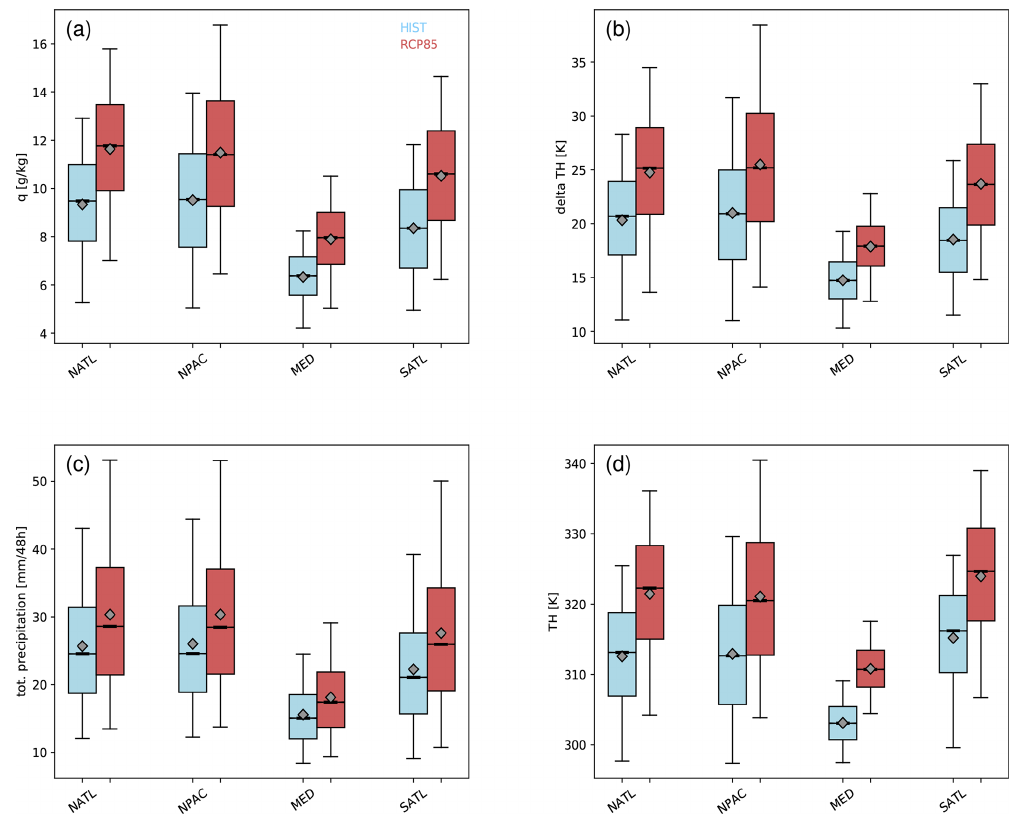
Figure 8. Box-and-whisker plots for different characteristics of WCBs in the North Atlantic (NATL), North Pacific (NPAC), Mediter- ranean (MED), and South Atlantic (SATL). The panels show (a) specific humidity in the WCB inflow, (b) the increase in potential tempera- ture along the WCB, (c) accumulated surface precipitation along the WCB, and (d) potential temperature at the end of the WCB ascent. Only winter is considered, i.e. DJF for NATL, NPAC, and MED and JJA for SATL. The results for HIST are shown in blue and for RCP8.5 in red bars. The diagrams show: the interquartile range (coloured bar), median (bold black line), mean (diamond), and the 5th-to-95th-percentile range (thin